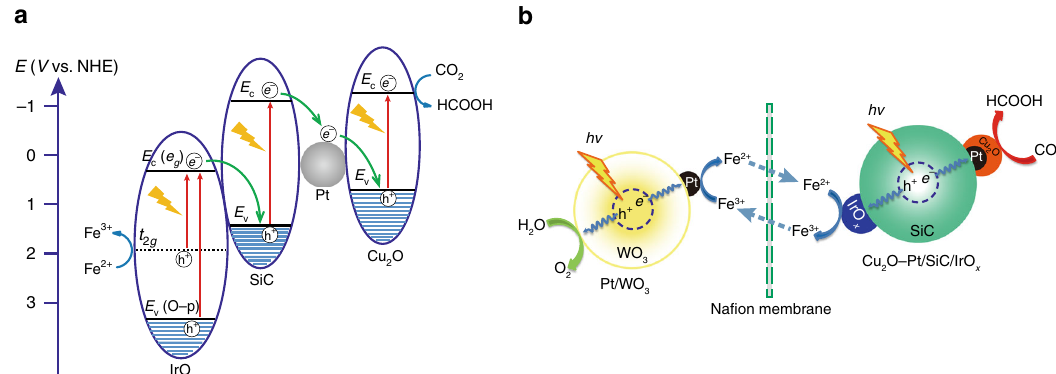
Fig. 9 Electronic structure and photocatalytic mechanism. a The electron transfer processes in Cu 2 O – Pt/SiC/IrO x under light illumination. b The proposed mechanism of the separated system for the ef fi cient CO 2 reduction and O 2